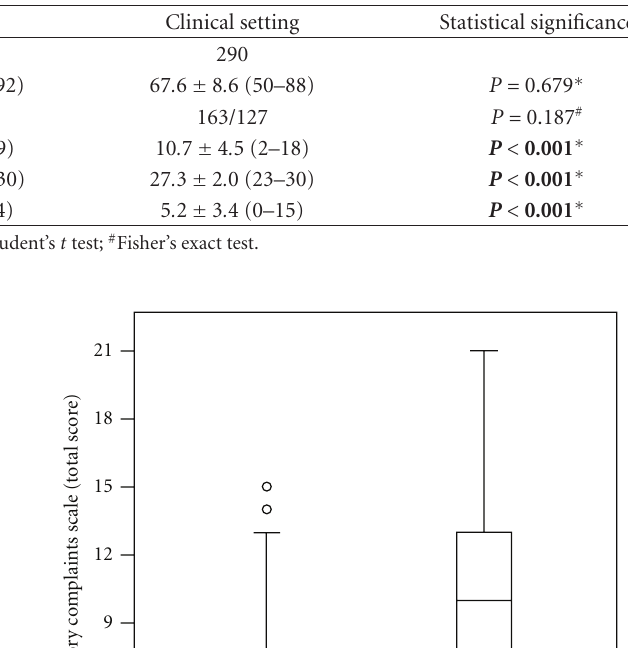
Table 1: Characteristics of the participants.